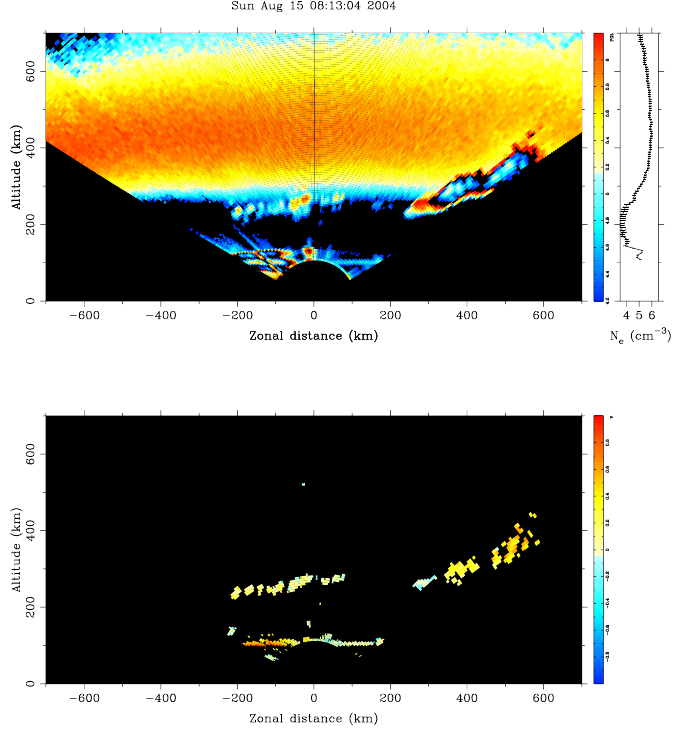
Fig. 10. Altair radar perpendicular scan for 15 August 2004, 08:13 UT.